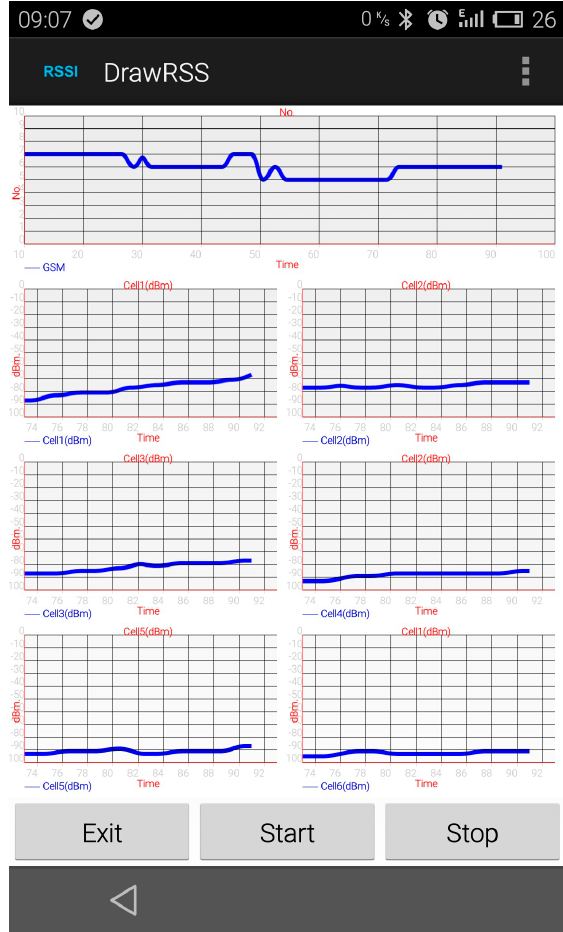
Figure 2. Screenshot of the DrawRSS application. In this application, all the neighboring cellular base stations’ signal strengths are drawn on the canvas and recorded in the phone’s memory.